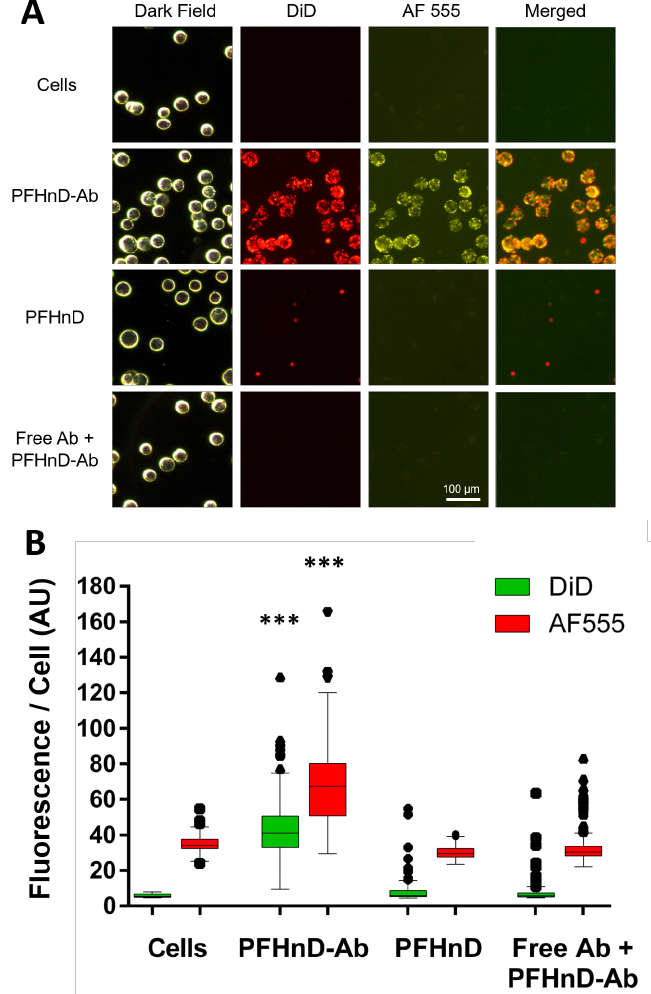
Figure 4. ( A ) FaDu cells were imaged using a fluorescent microscope for the different groups; cells, cells with targeted PFHnD-Abs, cells with non-targeted PFHnDs, and cells that were exposed to unla- beled free antibody prior to incubating with targeted PFHnD-Abs (blocking study). DiD lipophilic dye was embedded into the PFHnD-Ab and PFHnDs, while the antibodies were fluorescently labeled with AF 555. Dark-field cell images were used to identify the location of each cell in the image. The locations were then used to compute the fluorescent signal within the cell. Merged images show the two fluorescent channels (DiD and AF 555) overlaid. ( B ) The mean DiD and AF 555 fluorescence per cell for each group was computed from the fluorescent images, resulting in the PFHnD-Ab group hav- ing a statistically significant (*** = p < 0.001) higher mean DiD and AF 555 fluorescence/cell compared to the all other groups. There was not any statistical significance between the control